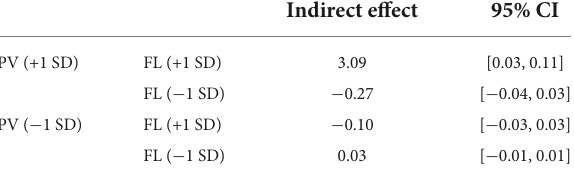
TABLE 5 The results of two-stage moderated